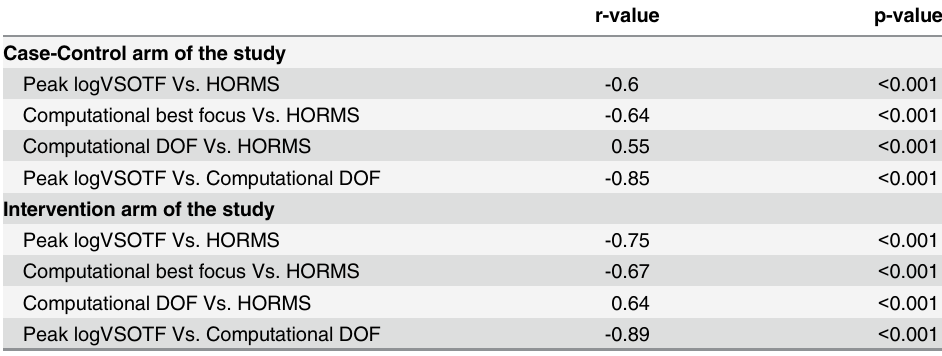
Table 1. Results of the computational analyses performed in the first and second arms of the study. Spearman ’ s rank correlation coefficient and the corresponding p-value obtained between the outcome vari- ables used in this